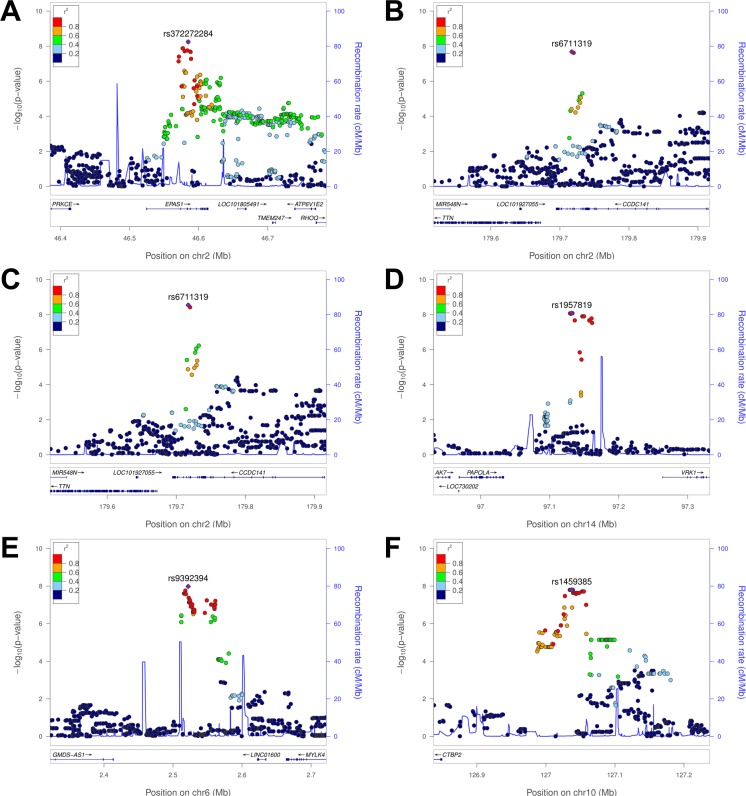
Locuszoom plots of the genome-wide significant associations found in Tibetans: (A) oxyHb and rs372272284 in the EPAS1 gene, (B) the numbers of pregnancies or (C) live births and rs6711319 in the CCDC141 gene, (D) the number of stillbirths and rs1957819 near the PAPOLA gene, (E, F) the proportion of offsprings died before age 15 years among the born alive and rs9392394/rs1459385. (A-C, E) are tests with all samples and (D, F) are those with the continuously married subset.